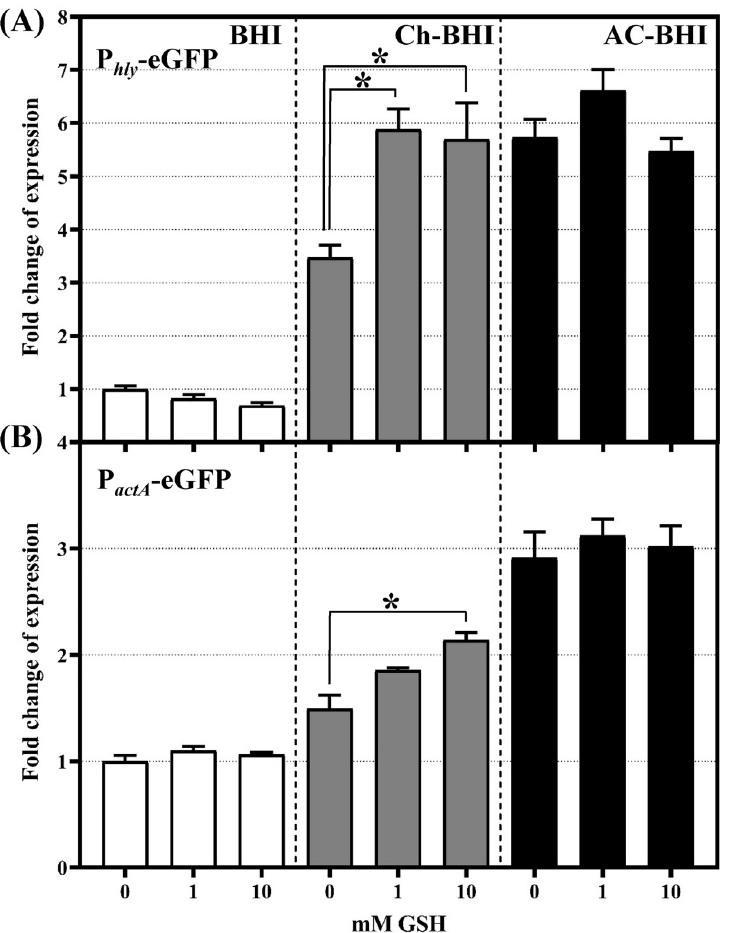
Fig 4. Expression of P -eGFP and P -eGFP in the presence of exogenously added glutathione (GSH). L . hly actA monocytogenes strains expressing P hly -eGFP (A) or P actA -eGFP (B) reporter fusions were grown in BHI (white bars), Ch-BHI (grey bars) or AC-BHI (black bars) with 0, 1 or 10 mM GSH. GFP fluorescence levels were measured and normalized by culture OD 600 . Fold change of expression (for graphing purpose) was calculated as a ratio of normalized GFP fluorescence level relative to the normalized fluorescence level of L . monocytogenes cells expressing the reporter fusion and growing in untreated BHI. Statistical analysis was done using the GFP/OD 600 data from at least 3 independent biological replicates; error bars represent SEM. An asterisk denotes a significant difference between the normalized fluorescence level at a given GSH concentration and the normalized fluorescence level in the absence of GSH ( p- value � 0.05) as determined by one-way ANOVA and Tukey’s post hoc test. P -eGFP and P -eGFP were not significantly affected by Chelex-treatment of BHI (Fig 5). mpl hpt Surprisingly, iron modestly induced P -eGFP expression (adjusted p -value < 0.0001 for Ch- inlA BHI+Fe vs BHI and 0.051 for Ch-BHI+Fe vs Ch-BHI), and P -eGFP expression (adjusted p - mpl value < 0.0001 for Ch-BHI+Fe vs Ch-BHI). On the other hand, GSH reduced the expression of P -eGFP in Ch-BHI (adjusted p -value 0.0011 for Ch-BHI vs Ch-BHI+GSH, Fig 5). Under inlA the tested growth conditions, P -eGFP expression was not affected by Chelex treatment of hpt BHI or by addition of iron, zinc, or GSH to Ch-BHI medium. These data indicate that relative levels of different metal ions and GSH differentially influence PrfA-dependent transcription of genes in the PrfA regulon, further supporting the notion that multiple extra- and intra-cellular cues are involved in the differential expression of members of the PrfA regulon [6,7].